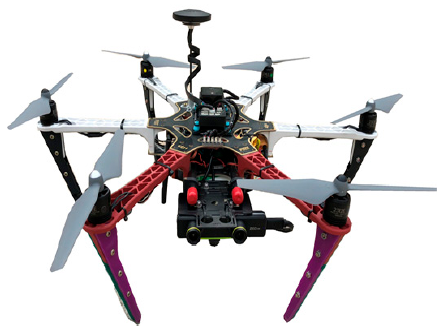
Figure 2. A hexacopter with a stereo camera.